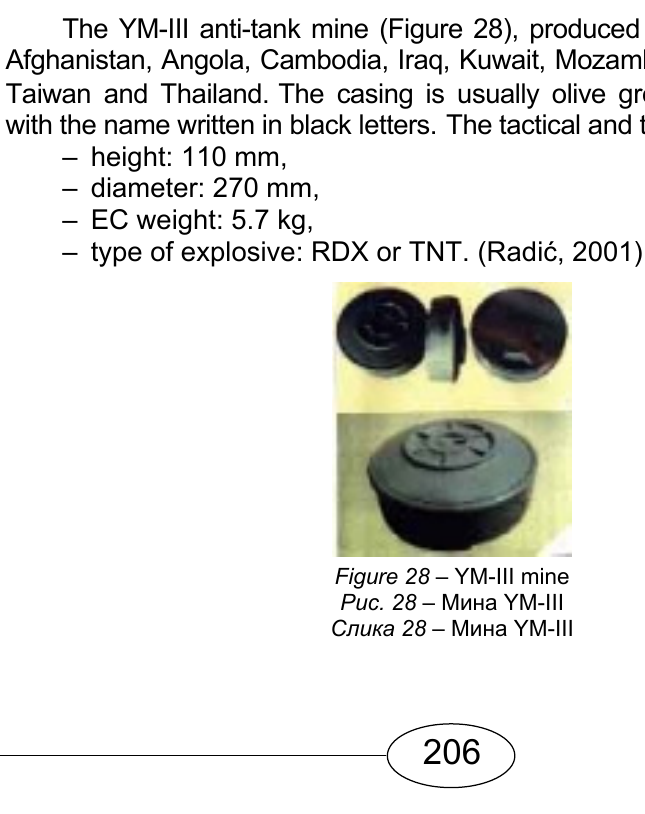
Figure 27 – PRB M3 mine Рис . 27 – Мина PRB M3 Слика 27 – Мина PRB M3